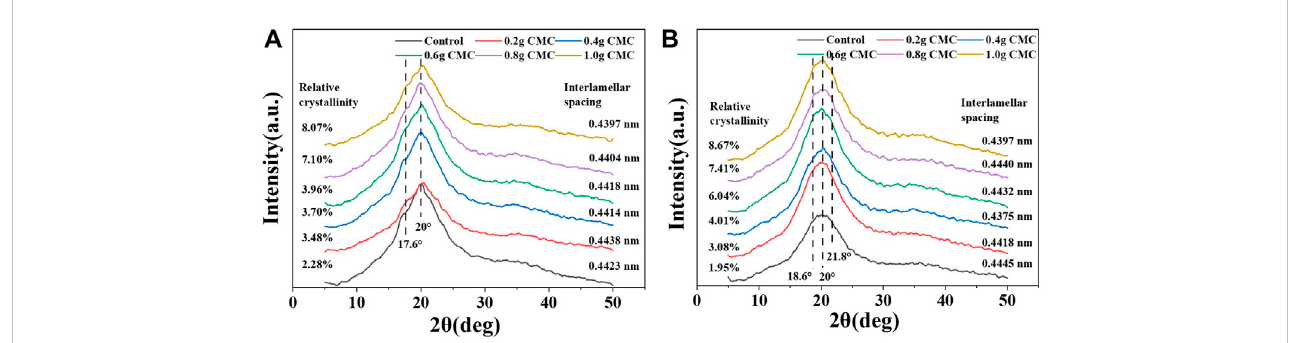
FIGURE 4 XRD curves of the starch/CMC composite fi lms. (A) : CS/CMC composite fi lms; (B) : CA/CMC composite fi lms.